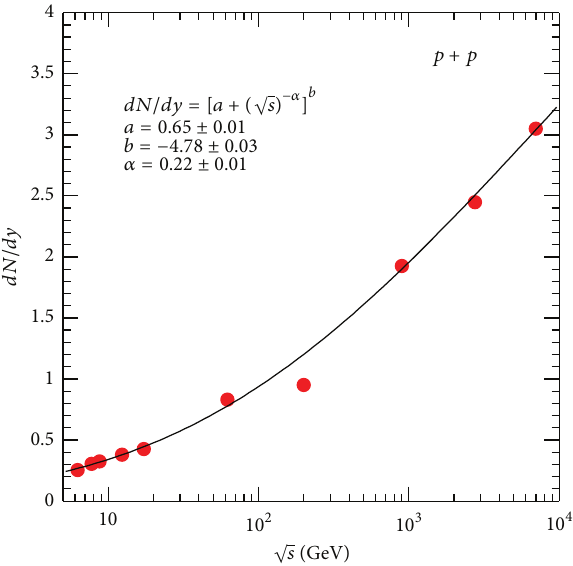
Figure 2: The variation of the Tsallis parameter 𝑛 for charged pions as a function of √𝑠 . The solid curve represents the parameterization (𝑎 + (√𝑠) −𝛼 ) 𝑏 .